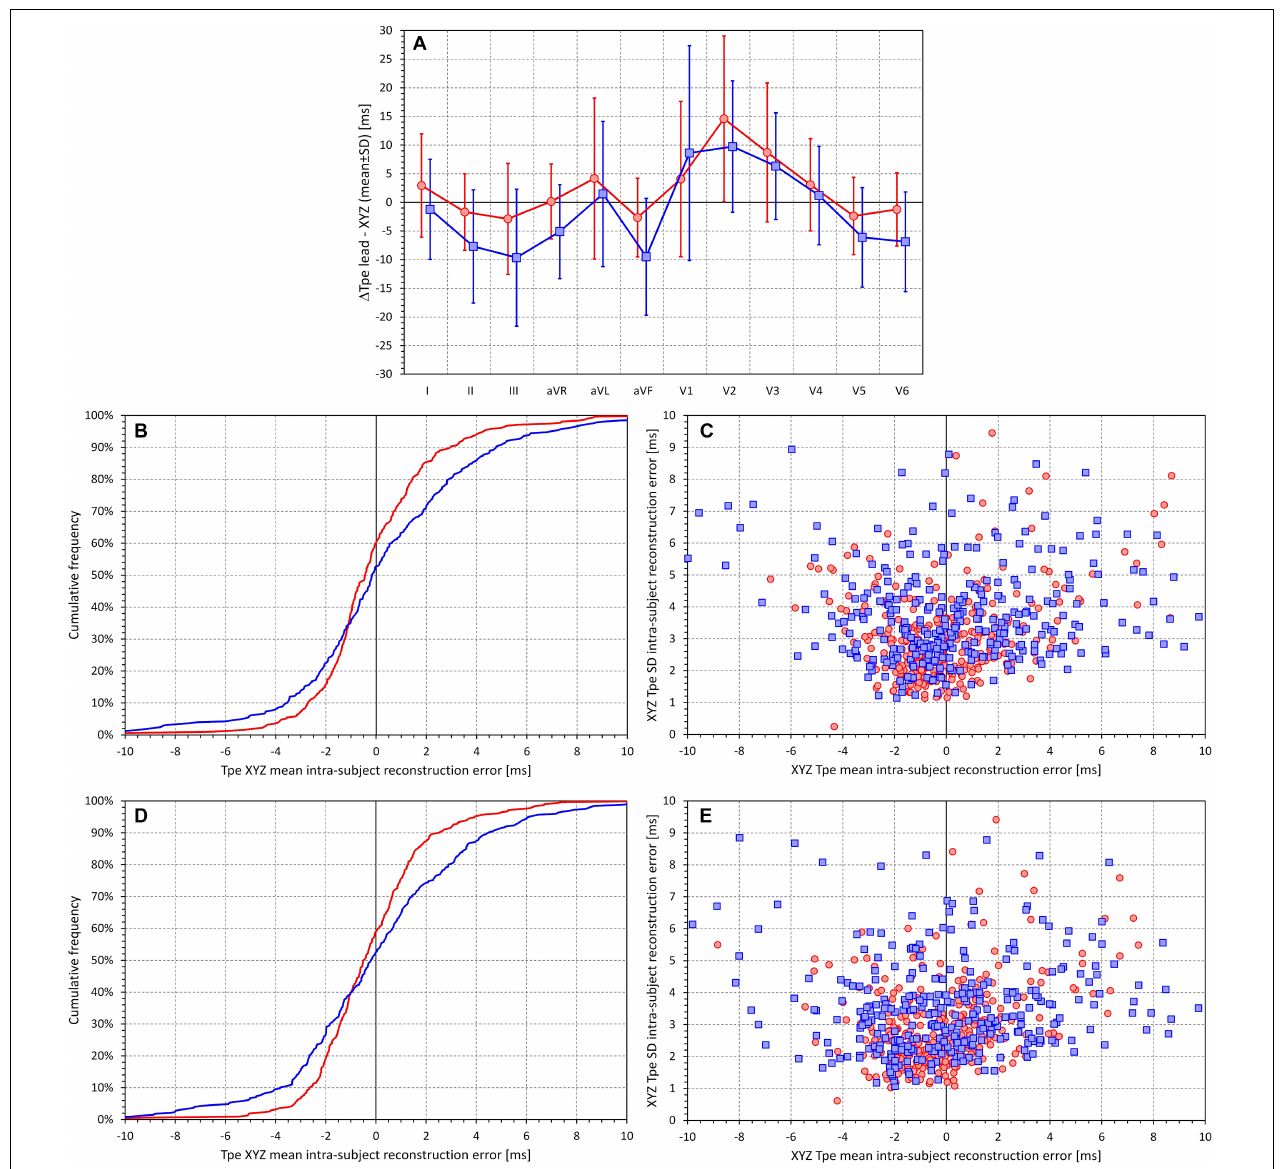
FIGURE 11 | For different electrocardiogram (ECG) leads, (A) shows the summaries of the differences between the Tpe measurements in the given lead and the Tpe measurements in the XYZ vector magnitude (analysis based on ECGs with complete measurements pooled together—see the text for details). (B,D) Cumulative distributions of the mean intrasubject differences between the Tpe intervals measured in the XYZ vector magnitude and their approximation by the restricted and complete regression models, respectively. (C,E) Scatter diagrams between the means and standard deviations of the intrasubject differences between the Tpe intervals measured in the XYZ vector magnitude and their approximation by the restricted and complete regression models, respectively (see the text for details). In (A) , the red and blue graphs correspond to the data in female and male subjects, respectively. In (B,D) , the red and blue lines correspond to female and male subjects, respectively. In (C,E) , the red circles and blue squares correspond to female and male subjects,